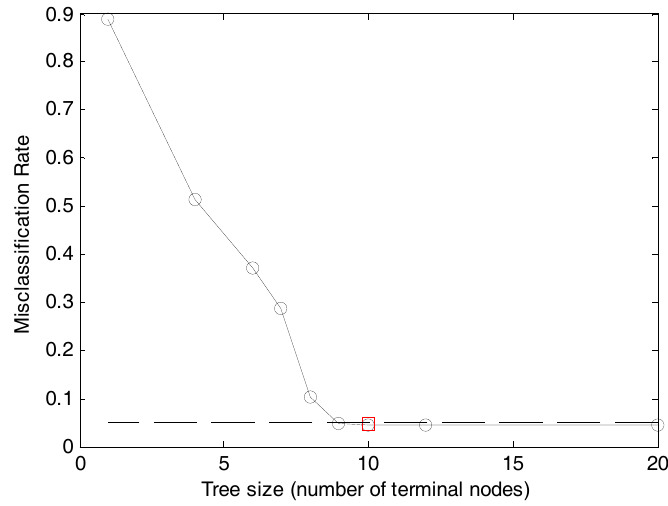
Figure 9. Cross-validation estimate of the misclassification rate.